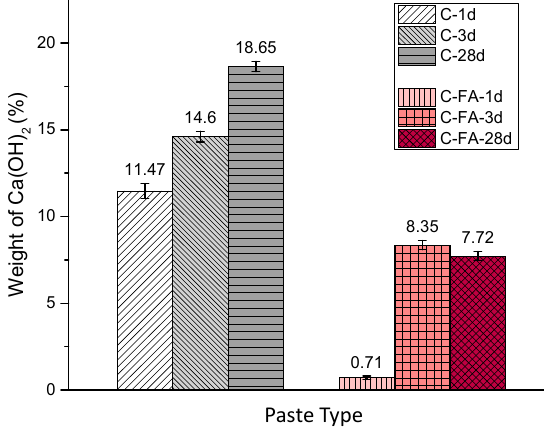
Figure 2. Results of thermal analysis. ( a ) TG and ( b ) DTG results of the C and C-FA.